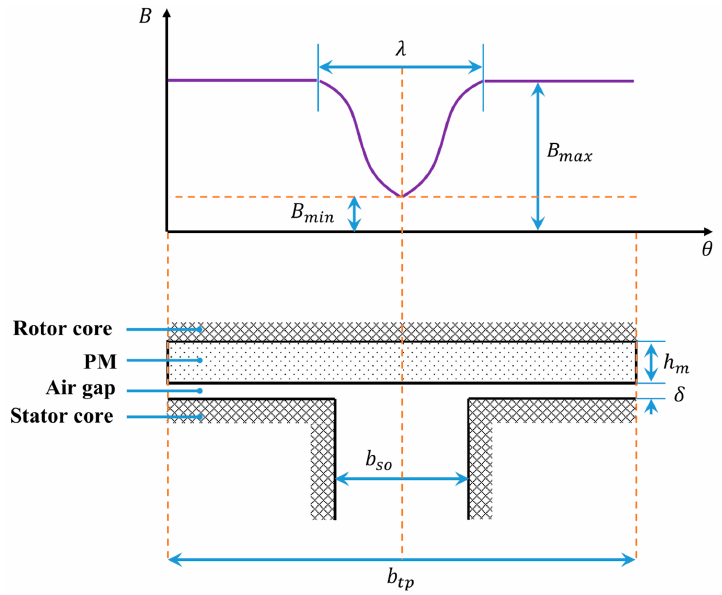
Figure 8. The single tooth pitch model for permeance expression derivation.